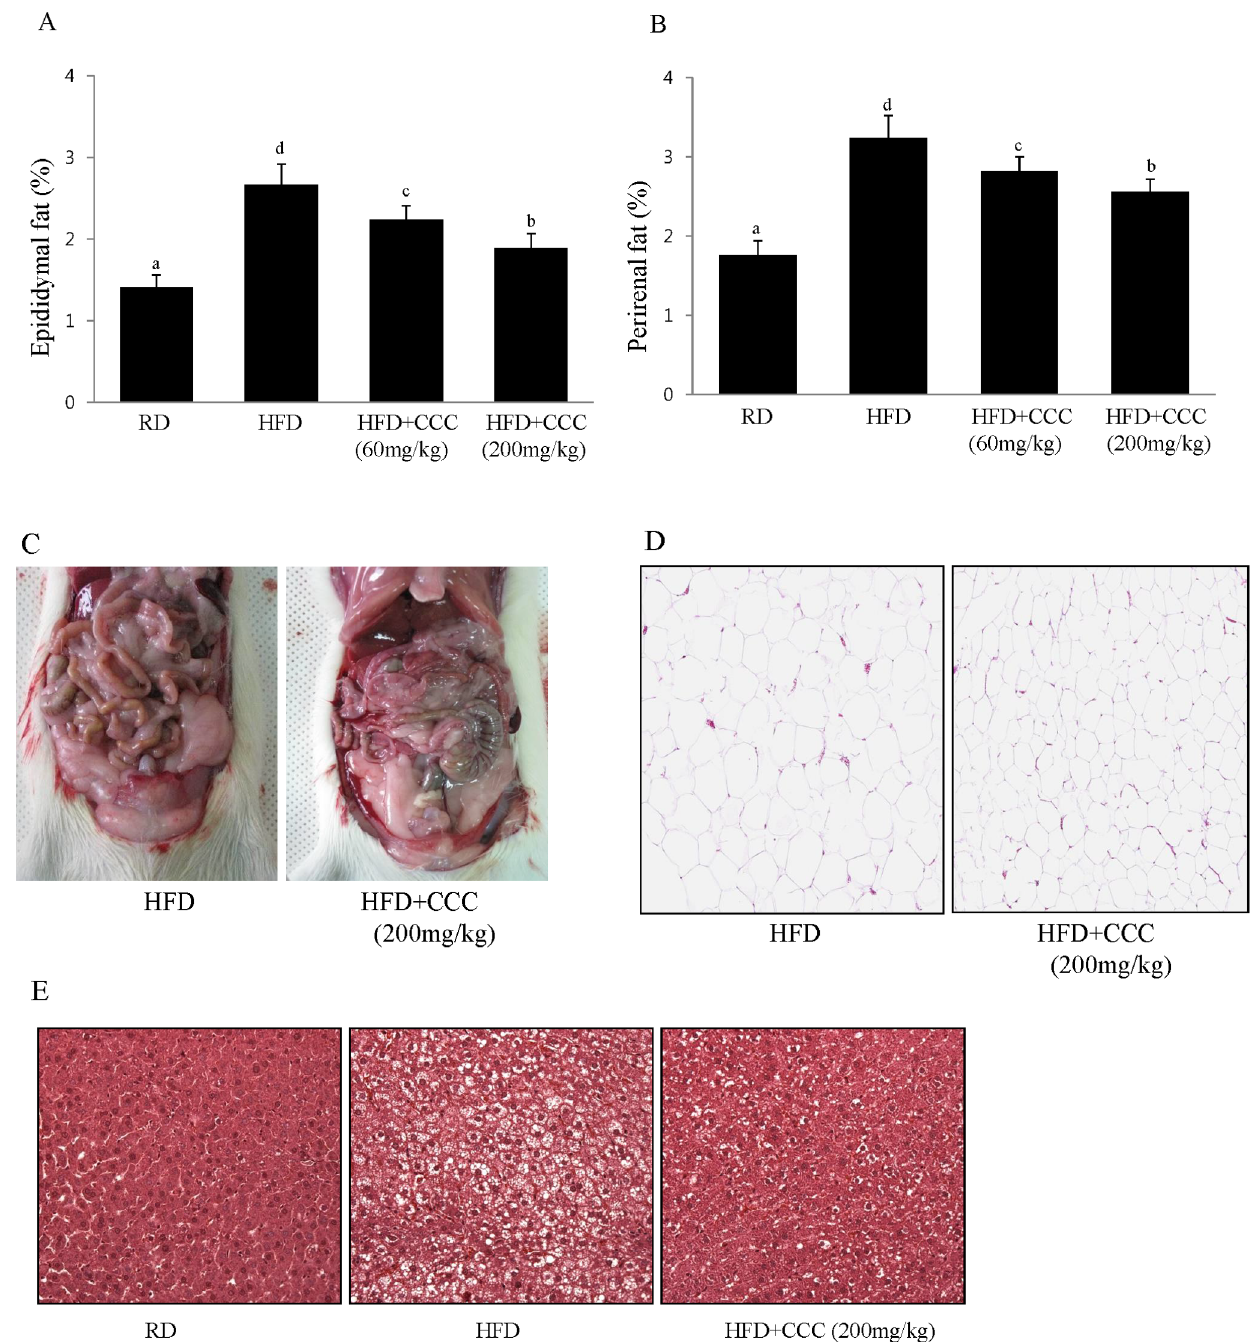
Figure 4. Treatment with CCC decreased the adipose tissue of the HFD-induced obese rats. The epididymal fat and perirenal fat weights were significantly decreased in the HDF + CCC (200 mg/kg) group compared to the HFD group. (A) Effects of CCC on epididymal fat weight. The weights of the epididymal fatty tissue were calculated by dividing the fatty tissue weight by the body weight (fatty tissue/body weight x 100). The values are expressed as the mean 6 SD. The bars with different letters are significantly different (*p , 0.05). (B) Effects of CCC on perirenal fat weight. The values are expressed as the mean 6 SD. The bars showing different letters indicate significant differences among each group of bars, according to Duncan’s test; *P , 0.05. The means sharing a common letter do not significantly differ. (C) Morphology of the fat tissue altered by CCC in the HFD- induced obese rats. (D) Histological staining of epididymal adipose tissue. Epididymal adipose tissues were isolated and stained with hematoxylin and eosin (H&E), then examined microscopically. Representative micrographs showing the reduced adipocyte size in the HFD + CCC (200 mg/kg) group are shown. (E) Representative H&E-stained liver section. Liver tissues were isolated and stained with H&E, then examined microscopically. Representative micrographs showing the reduced number and size of lipid droplets in the HFD + CCC (200 mg/kg) group are shown.